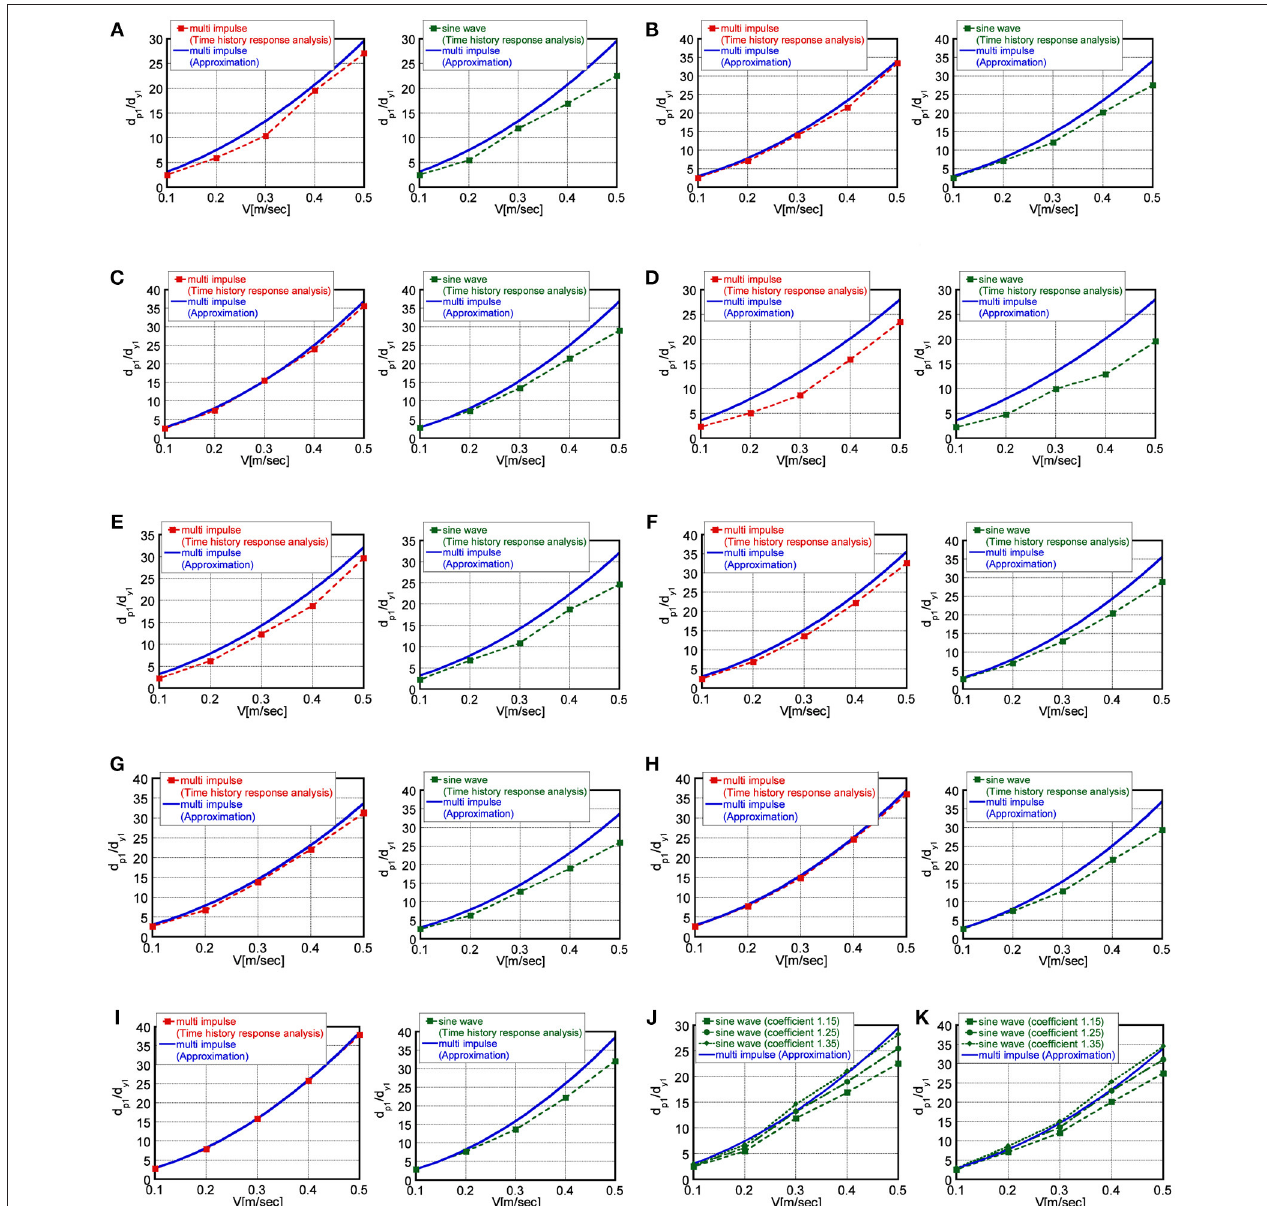
FIGURE 12 | Comparison among plastic deformation amplitude under critical multiple impulse by approximate solution, that under critical multiple impulse calculated by varying time interval (time history response analysis) and that under corresponding multi-cycle sinusoidal wave (time history response analysis);